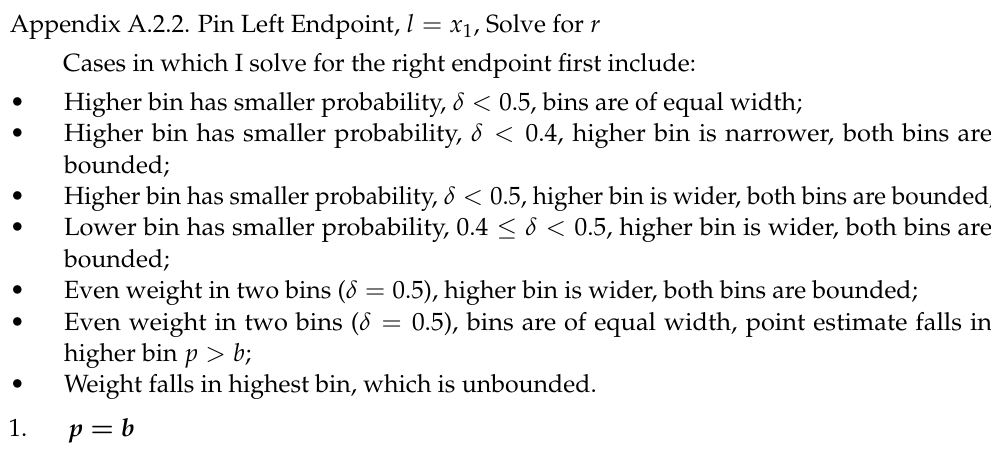
Figure A4. Point estimate in lower bin, Case